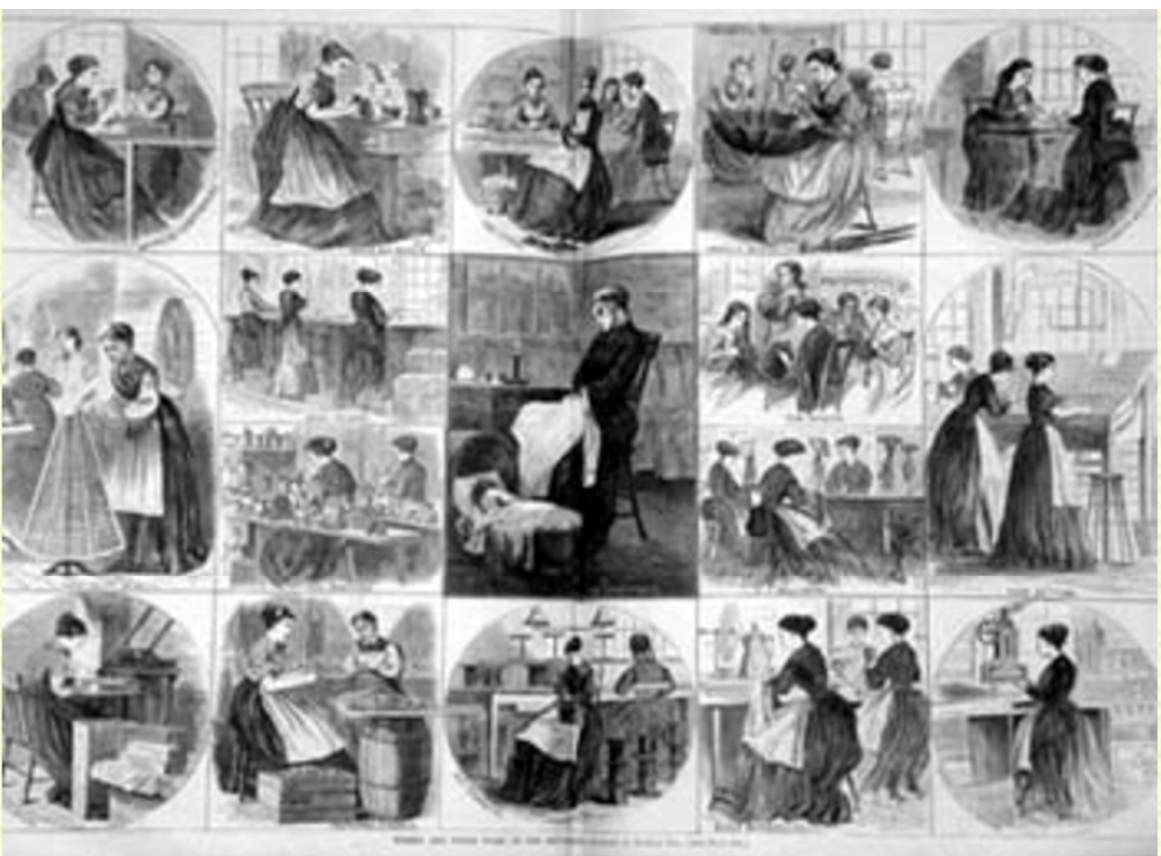
Figure 10. “Women and their Work in the Metropolis.” Harper’s Bazar ( April 1868). The American Antiquarian Society. Available online: http://commonplace.online/article/let-them-study-as-men- and-work-as-women/ (accessed on 30 May 2022).